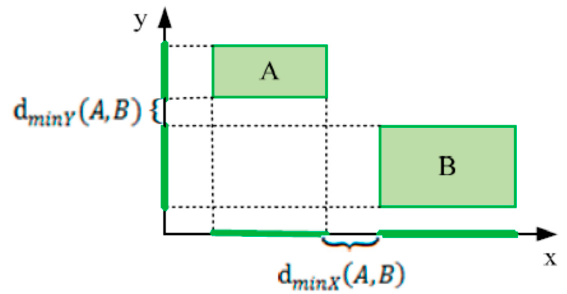
Figure 6. Minimum distance between projections of A and B in x and y dimensions.